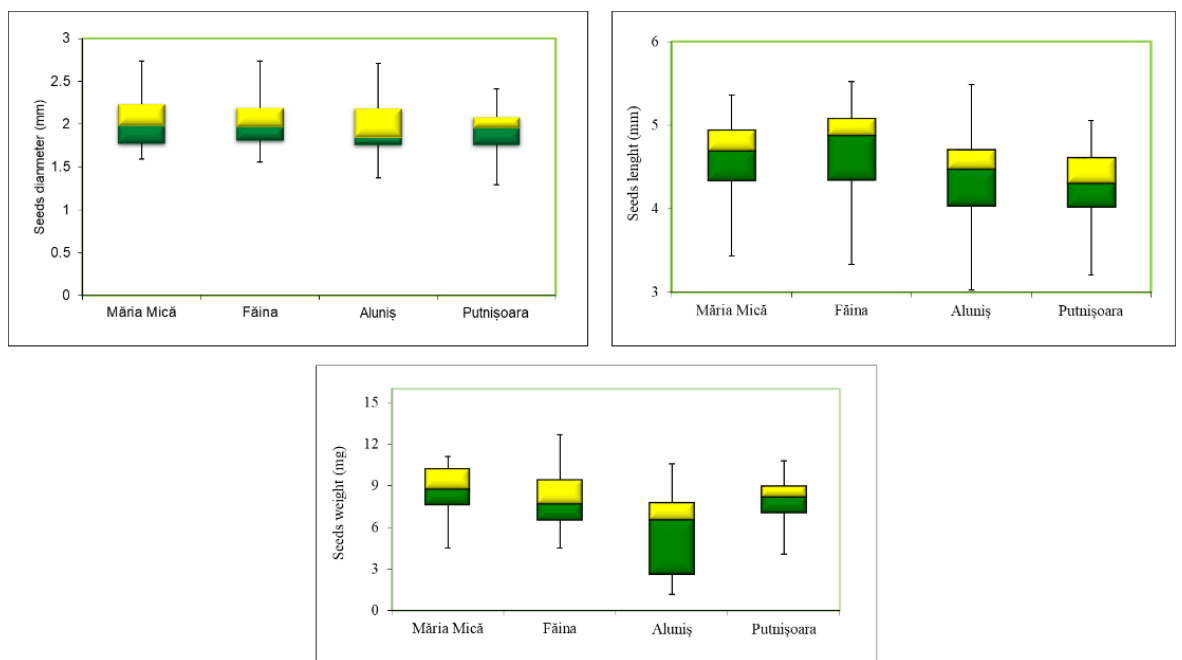
Figure 3. Chart diagrams of spruce seed length, diameter, and weight. Each box plot represents the minimum, median, and maximum values (yellow represents the maximum values and green represents the minimum values).